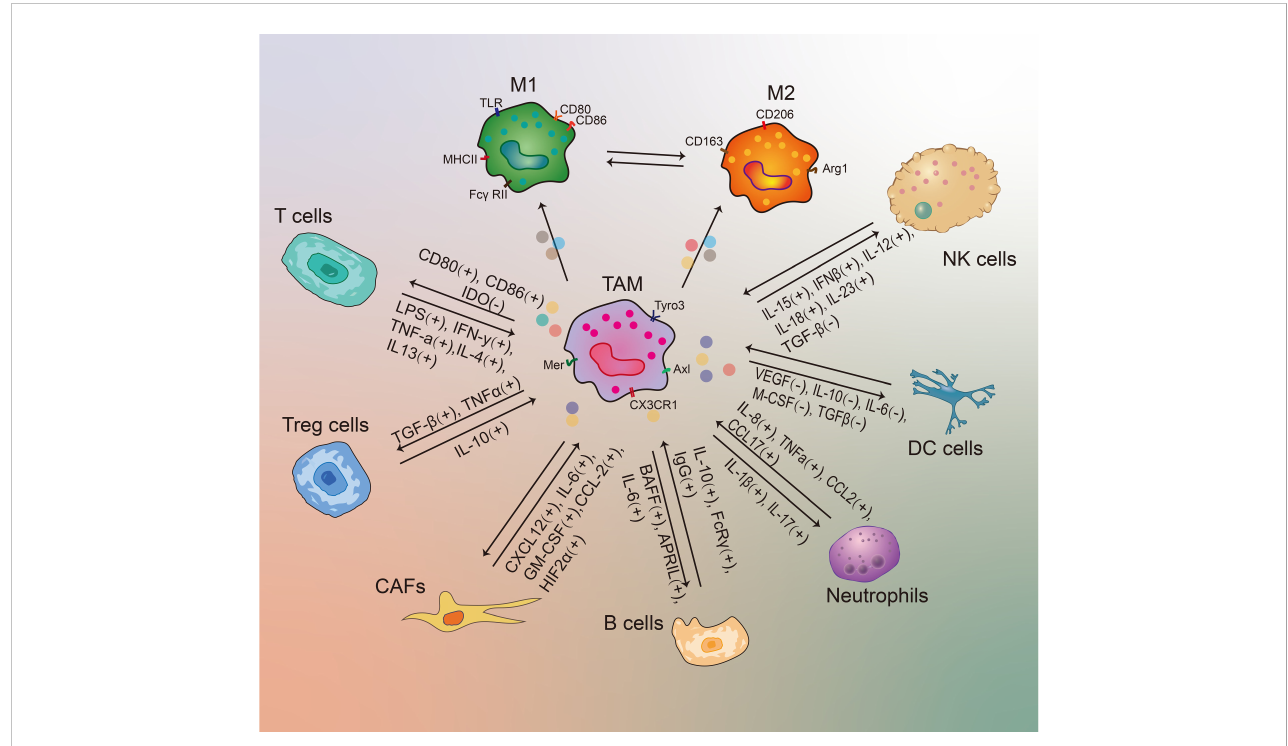
FIGURE 3 The molecular interactions between TAMs and other immune cells in the TME. A “ + ” or “ - ” sign shows a stimulatory or inhibitory